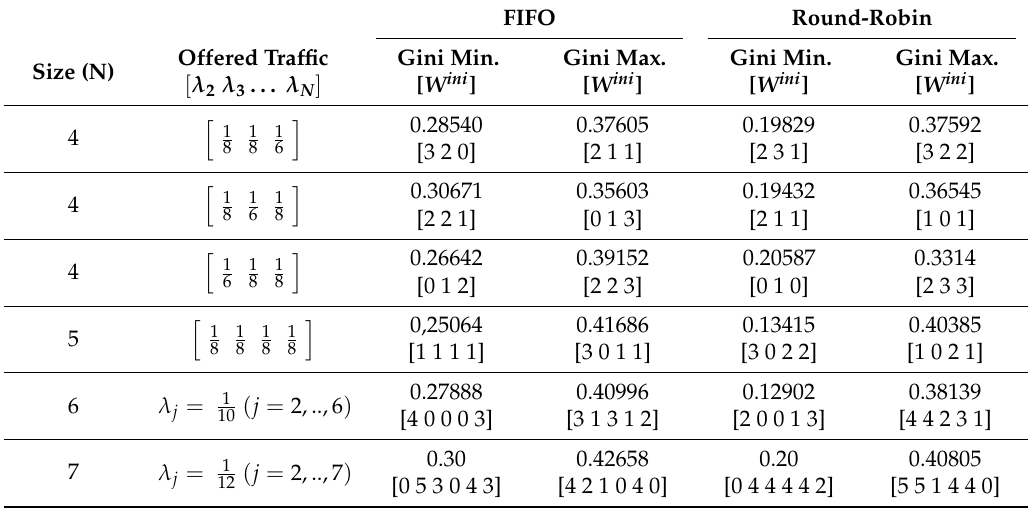
Table 5. Bounds for delay Gini index (optimal scheduling). Simulation time: 1000 time slots. FIFO